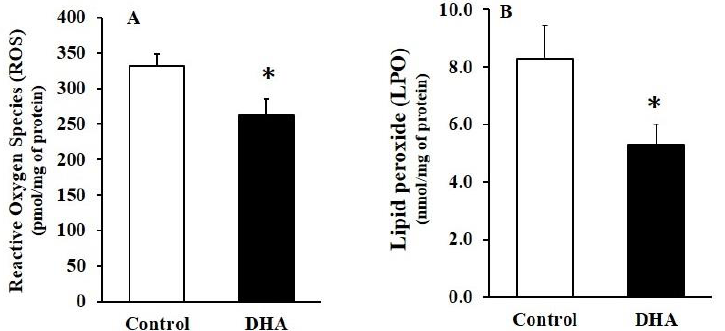
Figure 3. The effect of chronic oral administration of DHA on the levels of reactive oxygen species (ROS) ( A ) and lipid peroxide (LPO) ( B ) in the rat hippocampus. The results are mean ± SEM ( n = 10), each with duplicate determinations; * p < 0.05 versus control group.